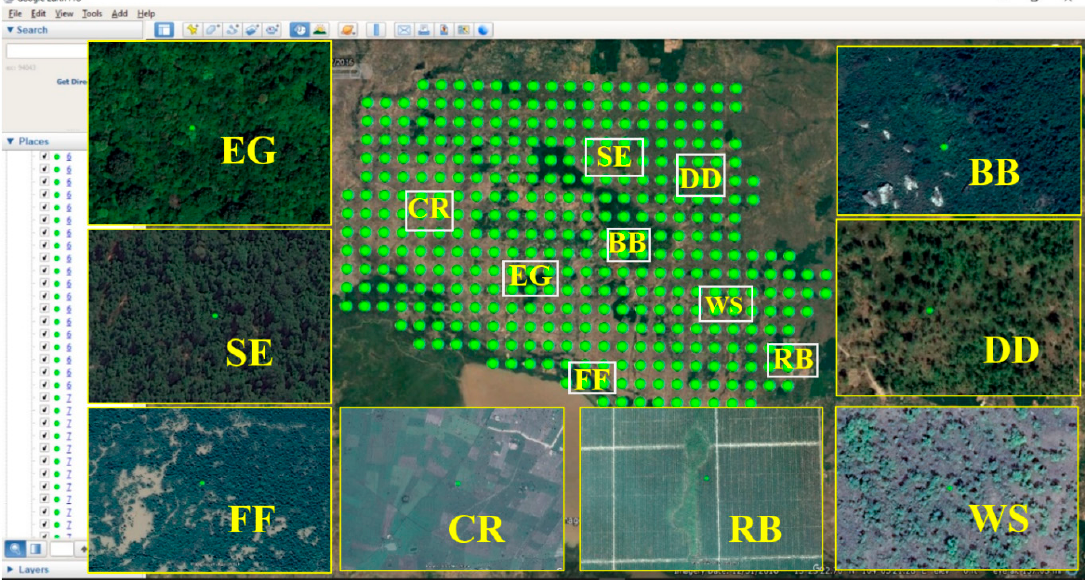
Figure 4. Maps showing the locations of accuracy points for accuracy assessment using Google Earth high-resolution imagery. These points were used to verify and validate the PBTC land cover categories, namely, the Evergreen forest (EG), Semi-Evergreen forest (SE), Deciduous forest (DD), Mixed woods and shrubs (WS), Bamboo (BB), Flooded forest (FF), Rubber plantation (RB), and Croplands (CR).